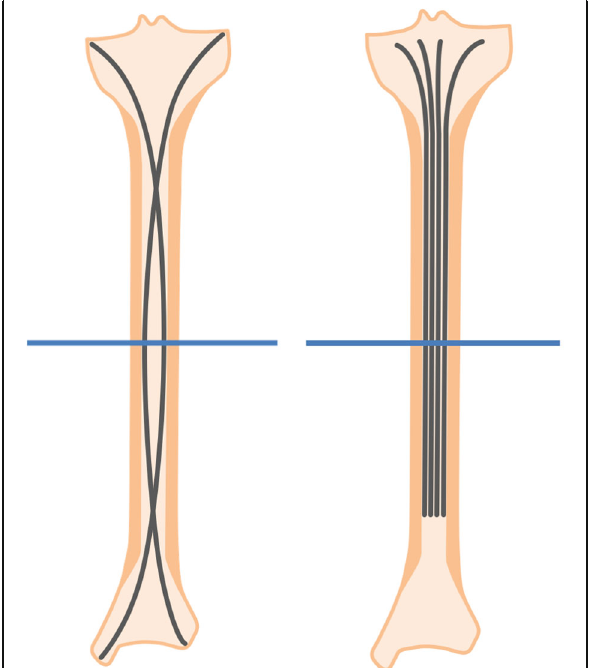
Fig. 5 Schematic representation of flexible (left) and bundle (right) intramedullary nailing techniques